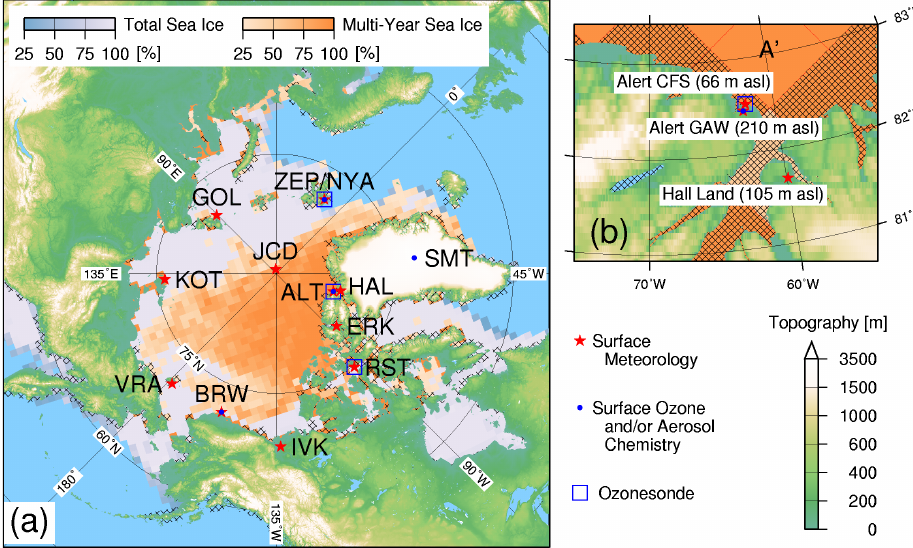
Fig. 2. (a) A circumpolar map showing the location of observation sites for surface meteorology (red stars), surface ozone and aerosol chemistry (blue dots) and ozonesonde sounding (blue open squares) used for evaluating the model simulations. ALT: the Canadian Forces Station (CFS) and the Global Atmosphere Watch (GAW) station at Alert, Ellesmere Island, Canada (66 and 210ma.s.l., respectively); BRW: Barrow NOAA/ESRL Observatory, Alaska, USA (8ma.s.l.); ERK: Eureka, Ellesmere Island, Canada (10ma.s.l.); GOL: Ostrov Golomjannyj, Russia (8ma.s.l.); HAL: Hall Land, Greenland (105ma.s.l.); IVK: Inuvik, Canada (68ma.s.l.); JCD: J-CAD 3 drifting buoy deployed near the North Pole; KOT: Ostrov Kotelnyj, Russia (8ma.s.l.); NYA: Ny ˚Alesund, Svalbard, Norway (18ma.s.l.); RST: Resolute, Cornwallis Island, Canada (67ma.s.l.); SMT: Summit, Greenland (3238ma.s.l.); VRA: Ostrov Vrangelja, Russia (5ma.s.l.); and ZEP: Zeppelin, Svalbard, Norway (474ma.s.l.). Also shown are the areas of higher than the 25% sea-ice concentration from the CMC analyses (light purple shading) overlaid with the areas of higher than the 25% multiyear sea-ice concentration from the QuikSCAT data (orange shading) for 15 April 2001. Both of the sea ice data are regridded to the horizontal resolution of the model. In the cross-hatched grid cells, snowpack on the sea ice is assumed to act in the same manner as the terrestrial snowpack for the air-ice/snow interactions of bromine in the model because the grid-mean terrain height exceeds 50ma.s.l. (see text); (b) A regional map focusing on the area around the Alert CFS and GAW sites in Ellesmere Island, Canada and Hall Land in Greenland. For evaluating simulated ozone mixing ratios at Alert, we also use the model output at the grid cell A 0 adjacent to the nearest grid cell for the Alert CFS and GAW